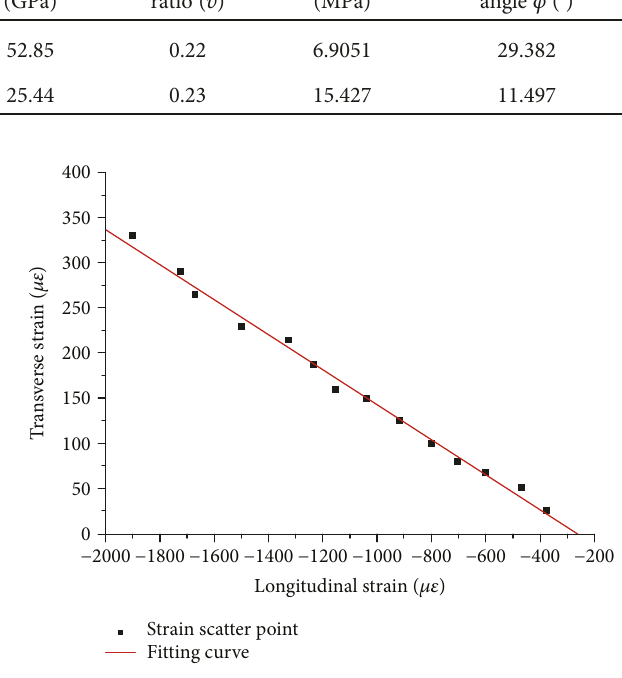
Figure 4: Poisson ’ s ratio fi tting diagram of K-2 sample.